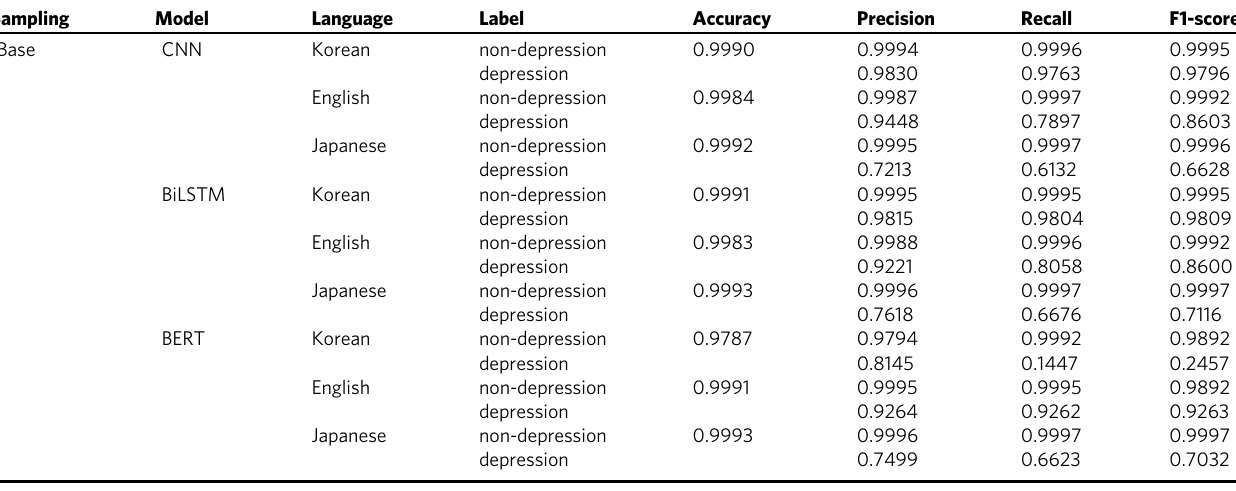
Table 4 Results of the binary classi fi cation task on Twitter with under-sampling.